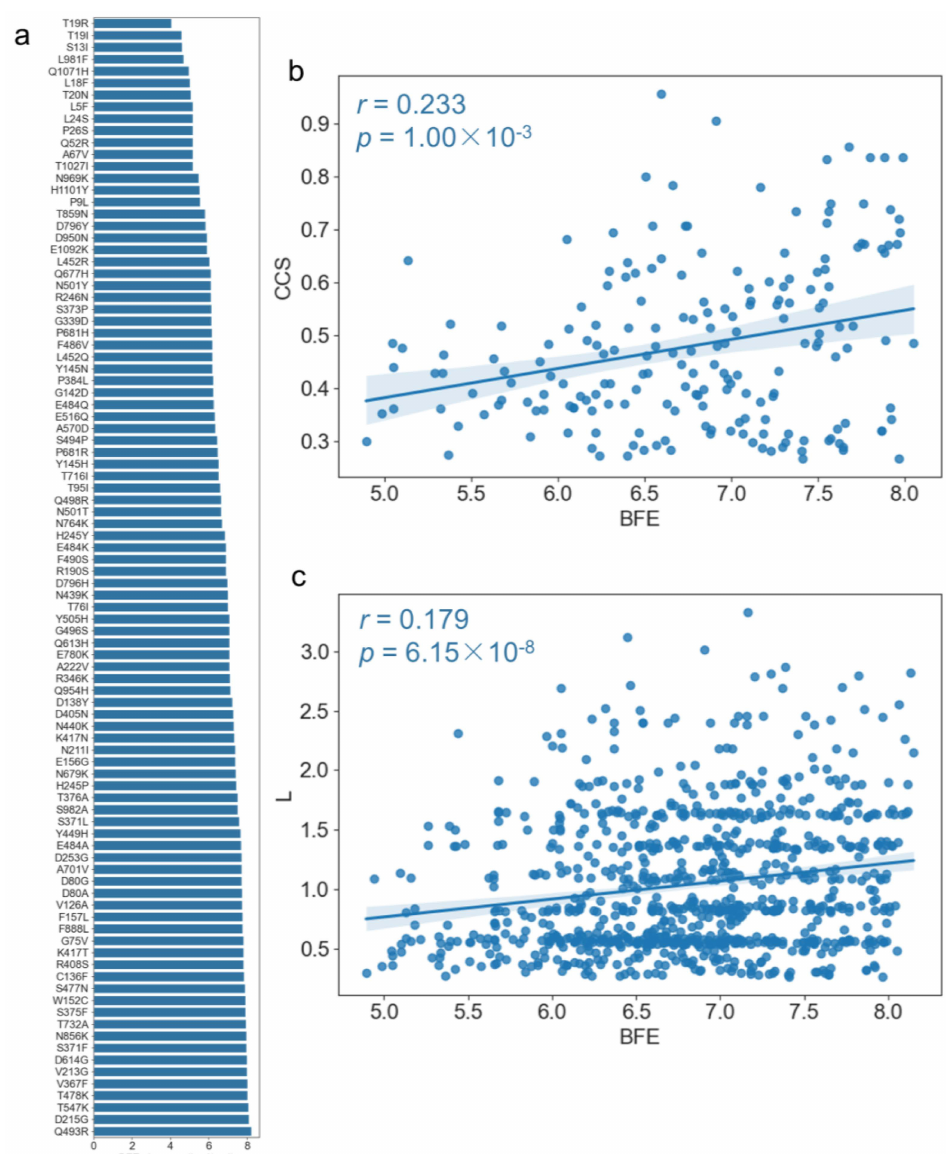
Figure 9. Correlation between the binding free energy changes of the spike protein upon mutations and the PCCN topological features. ( a ) Stability changes of the spike protein upon point mutations. ( b ) Page rank was positively significantly correlated with the stability changes. ( c ) BEF changes were positive significantly correlated with the average shortest path length L